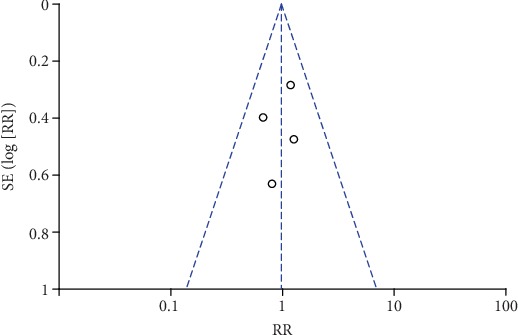
Funnel plot of PONV incidence.